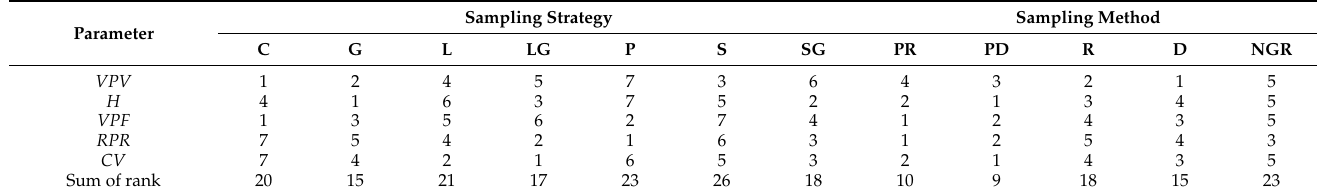
Table 4. The rank of sampling strategies, sampling methods and sampling scales within group in 203 primary core collections.